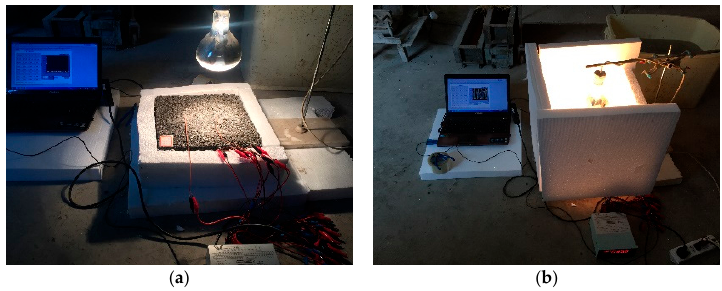
Figure 6. ( a ) The experimental devices; ( b ) The enclosure around the specimen.